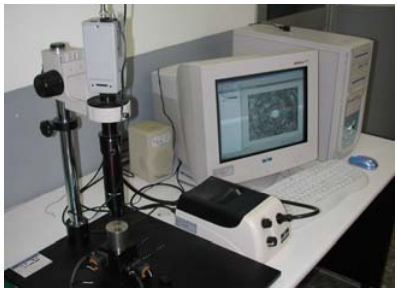
Figure 7. Measurement of tool frank wear.